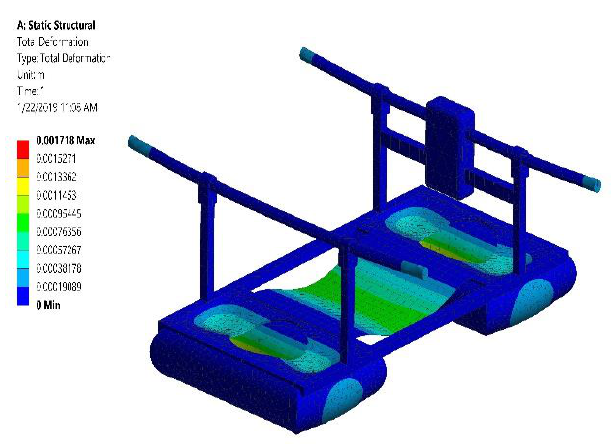
Figure 15. Deformation of amphibious